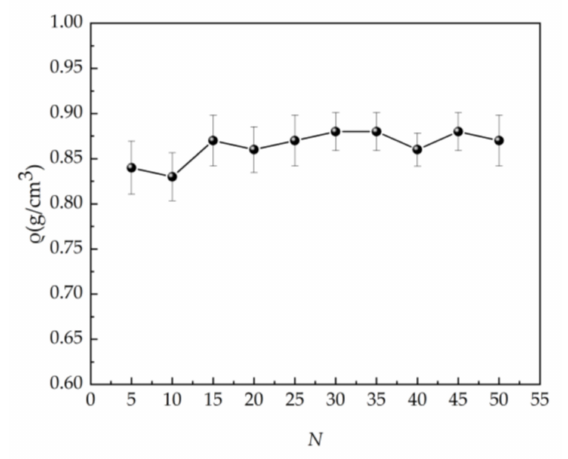
Figure 8. Density of EUG models with different degrees of